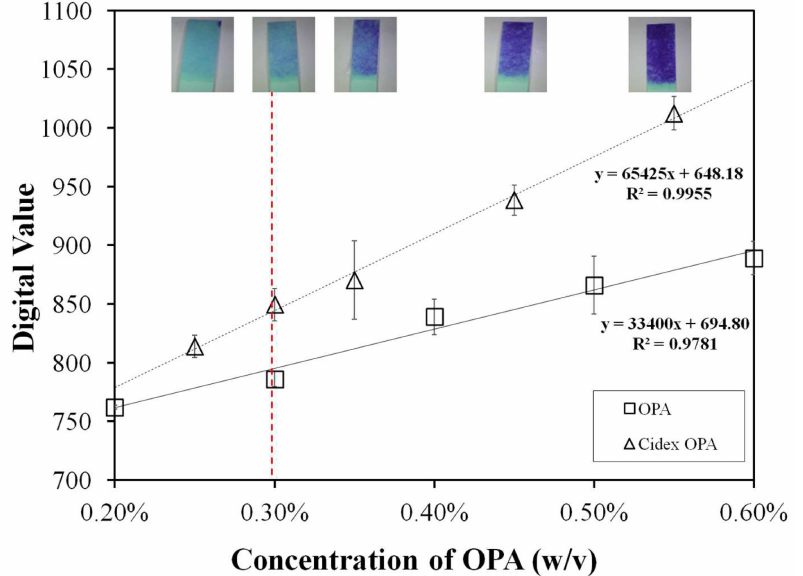
Figure 9. Calibration curve comparison of the OPA sensor between Cidex-OPA ( (cid:52) ) and reference OPA ( (cid:3) ). The hydrogel-modified SPCE strips were conditioned by exposing them to 5 µ L of OPA for 20 s before being applied with +0.8 V vs. Ag/AgCl. The digital amperometric output was recorded using a homemade potentiostat prototype based on the LMP91000EVM module. The color of Cidex-OPA test strip indicators corresponding to Cidex-OPA test concentrations was shown in the upper photographs. The minimum effective concentration (MEC) of Cidex-OPA disinfectant was indicated by the red dot